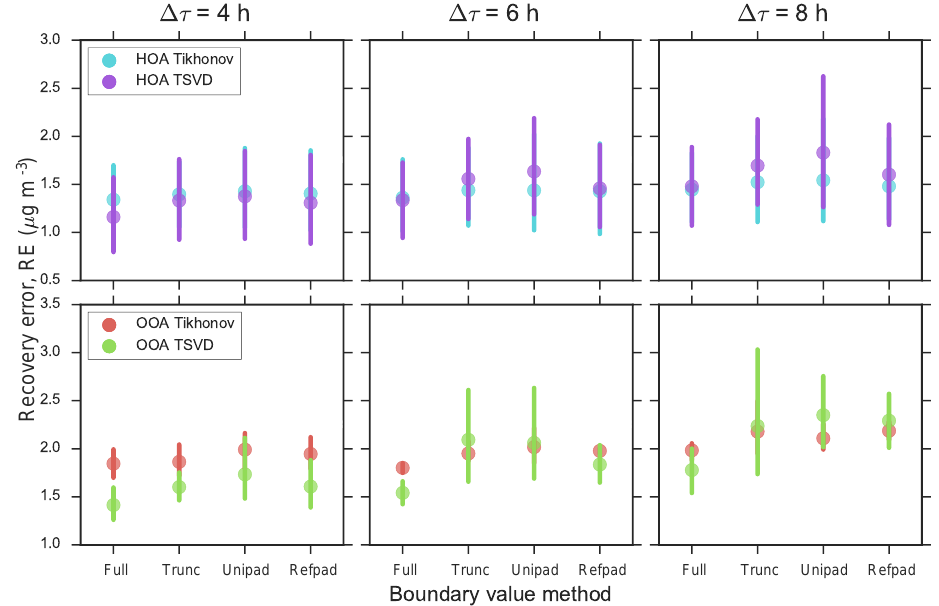
Figure 7. Mean recovery error (RE) for different boundary value methods for HOA and OOA time series constructed by deconvolution with TSVD and Tikhonov regularization of staggered measurements of length ( (cid:49)τ ) 4, 6, and 8h. κ m = 20% and T = 57h, meaning each data point is an average over 4 ( = 228 / 57) time series segments. The boundary value methods are full; trunc, truncated; unipad, uniformly padded; and refpad, reflectively padded. The vertical bars represent 95% confidence intervals determined by bootstrapping the mean